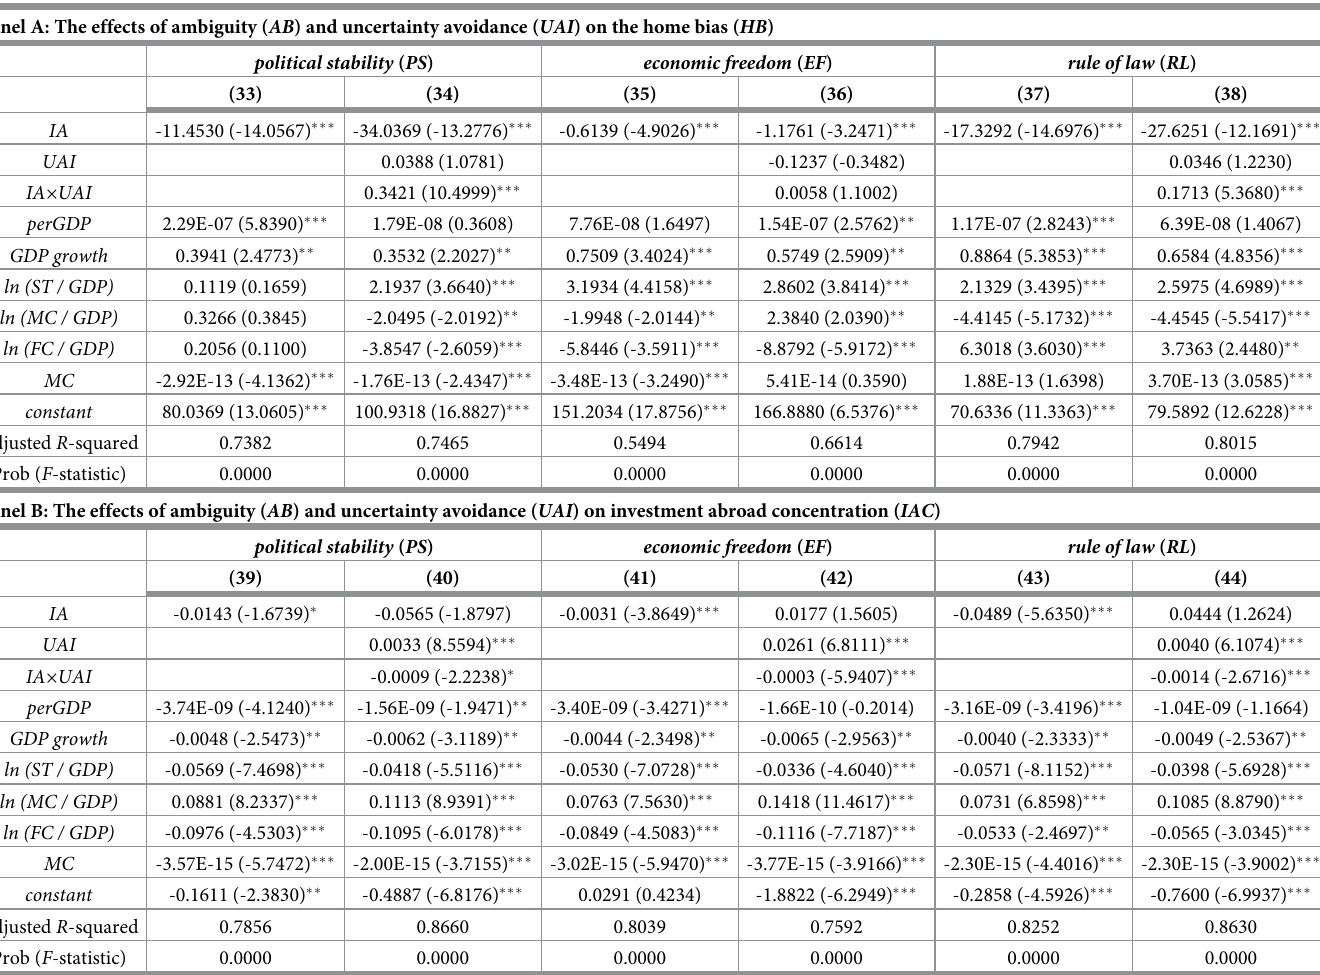
Table 7. The results of AB-UNDV and AB-UAI-UNDV models. Panel A: The effects of ambiguity ( AB ) and uncertainty avoidance ( UAI ) on the home bias ( HB )